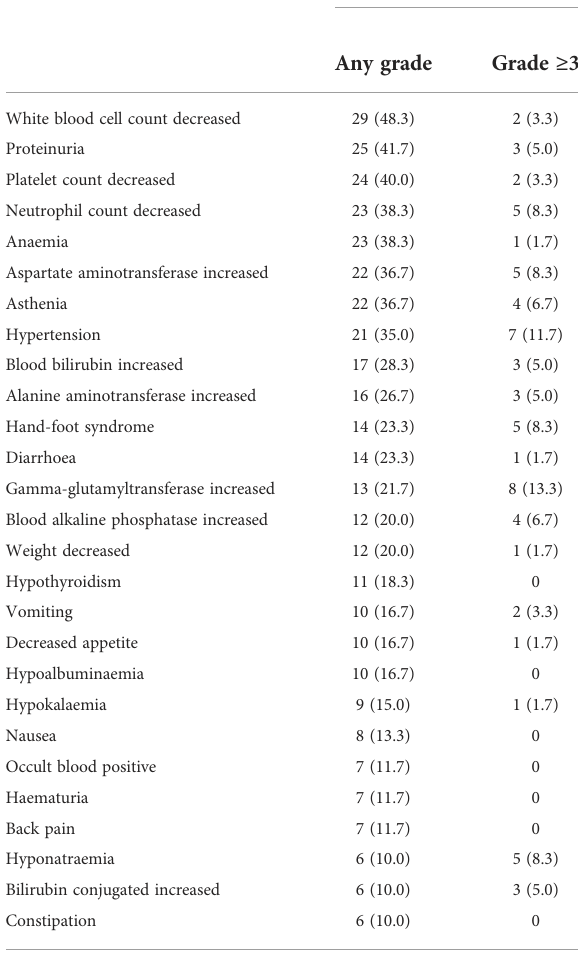
TABLE 4 Adverse events occurring in at least 10% of